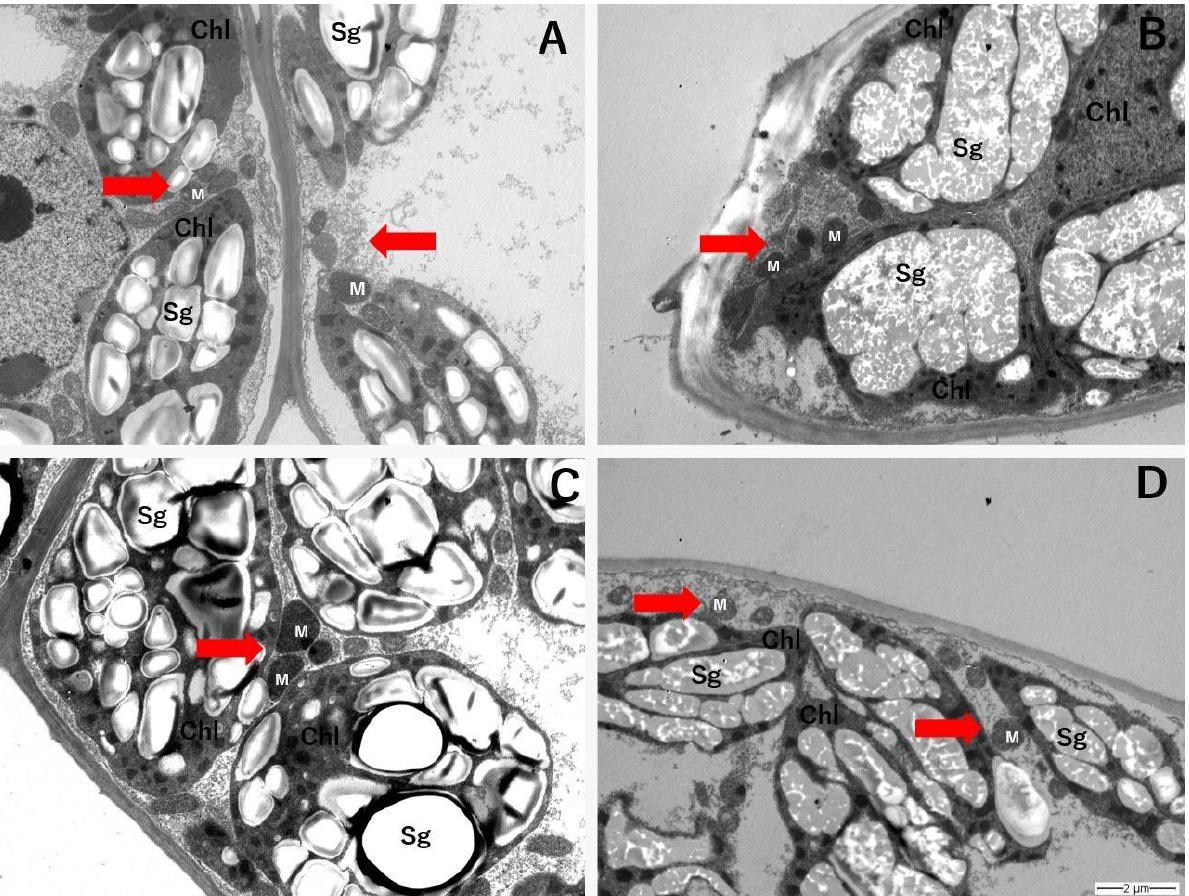
Figure 6. Mitochondria (M; red arrows), chloroplasts (Chl), and starch granules (Sg) from leaf mesophyll of C. quitensis exposed to AC (ambient CO 2 , control thermoperiod; A ), AW (ambient CO 2 , warming thermoperiod; B ), EC (elevated CO 2 , control thermoperiod; C ), and EW (elevated CO 2 , warming thermoperiod; D ) Microscope magnification = 6000X.